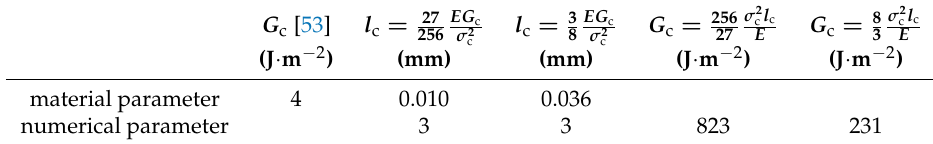
Table 4. Link between the fracture energy G c and the length-scale parameter l c seen as a material or numerical parameter using the Young modulus E = 70 GPa and the tensile strength for annealed glass σ c = 45 MPa from